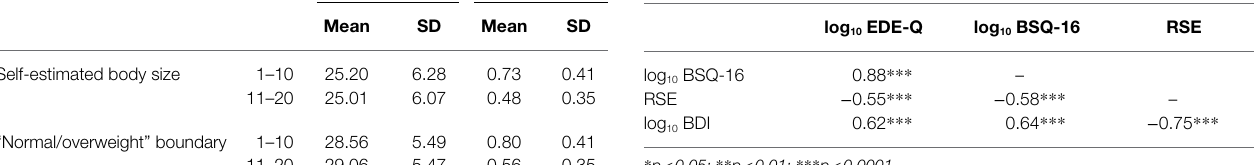
TABLE 2 | Split-half reliability analysis of MoA data. Condition